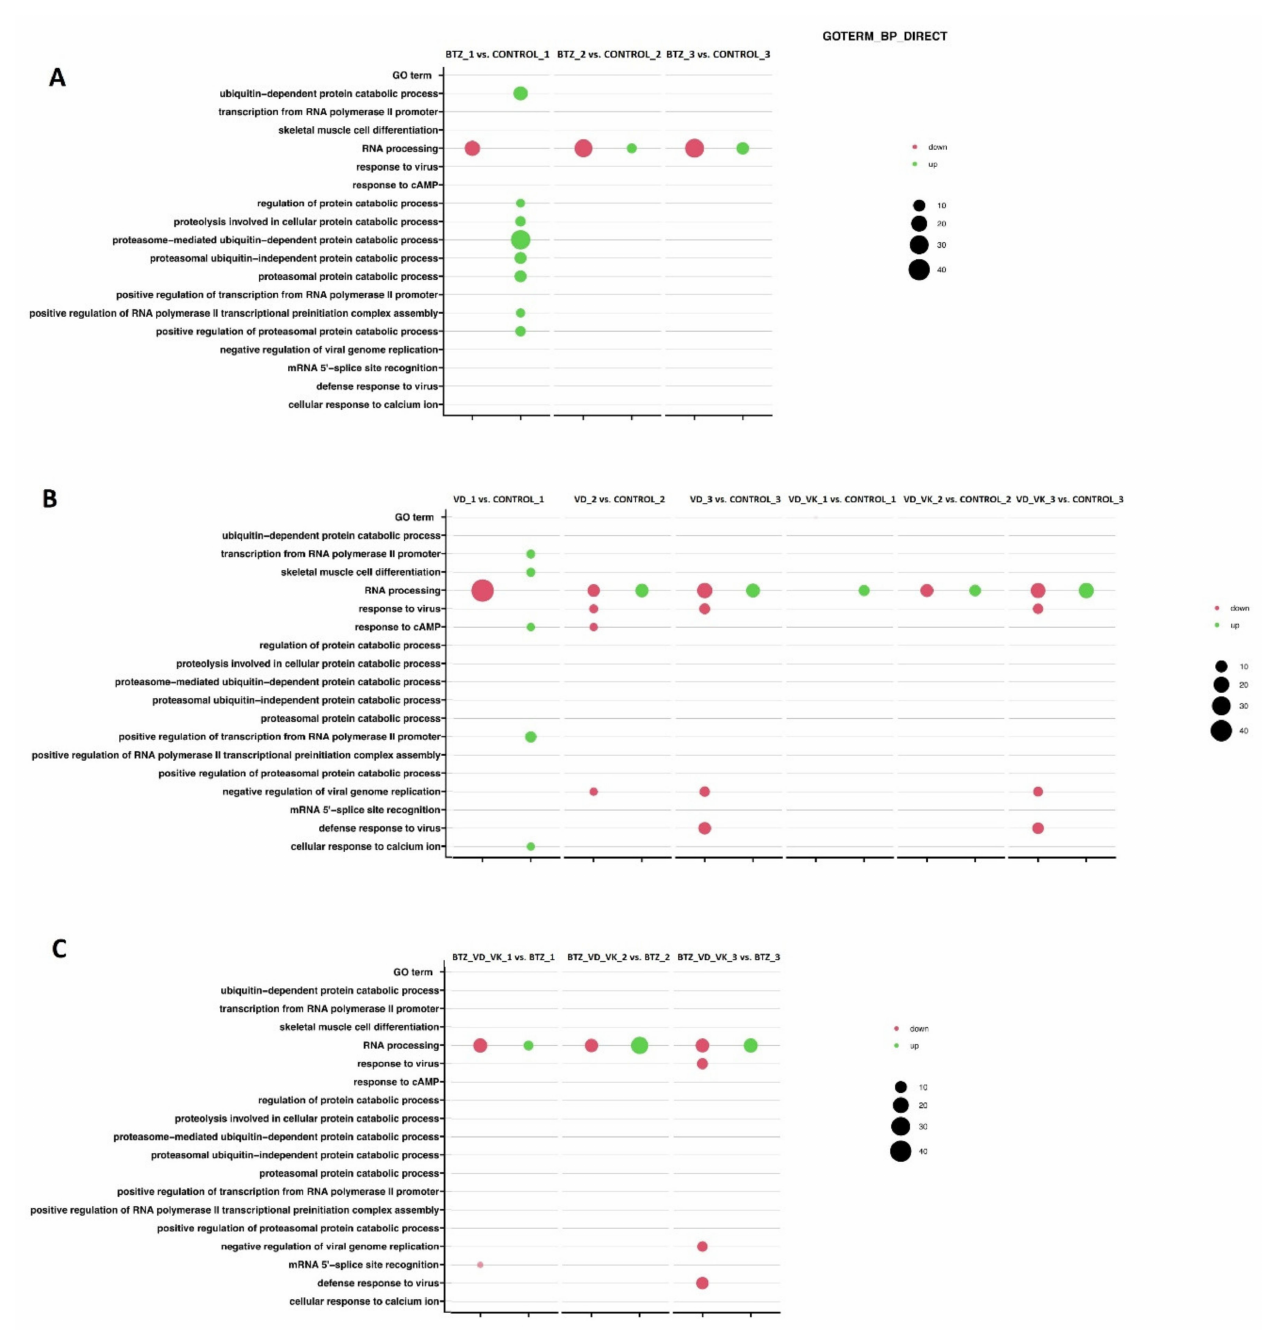
Figure 7. The bubble plot shows the biological processes involved in the development of BTZ resistance, the effects of VD and VK on myeloma cells and their role in the development of resistance to BTZ. The size of the bubble is proportional to the number of genes involved in the process. The red color of the bubble means inhibition of the biological process, and green means its increase ( p < 0.05, fold ≥ 2). Part of diagram ( A ) shows the processes after treatment with BTZ vs. control; ( B ) shows the processes after incubation with VD_VK vs. control; ( C ) shows the processes after treatment with BTZ_VD_VK vs.